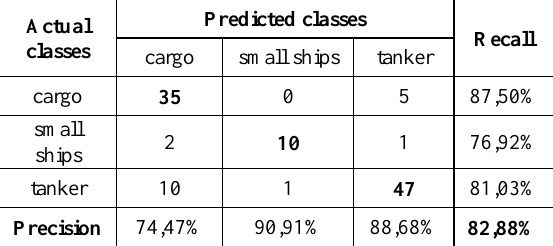
Table 4. Confusion matrix for the overall hierarchical classification